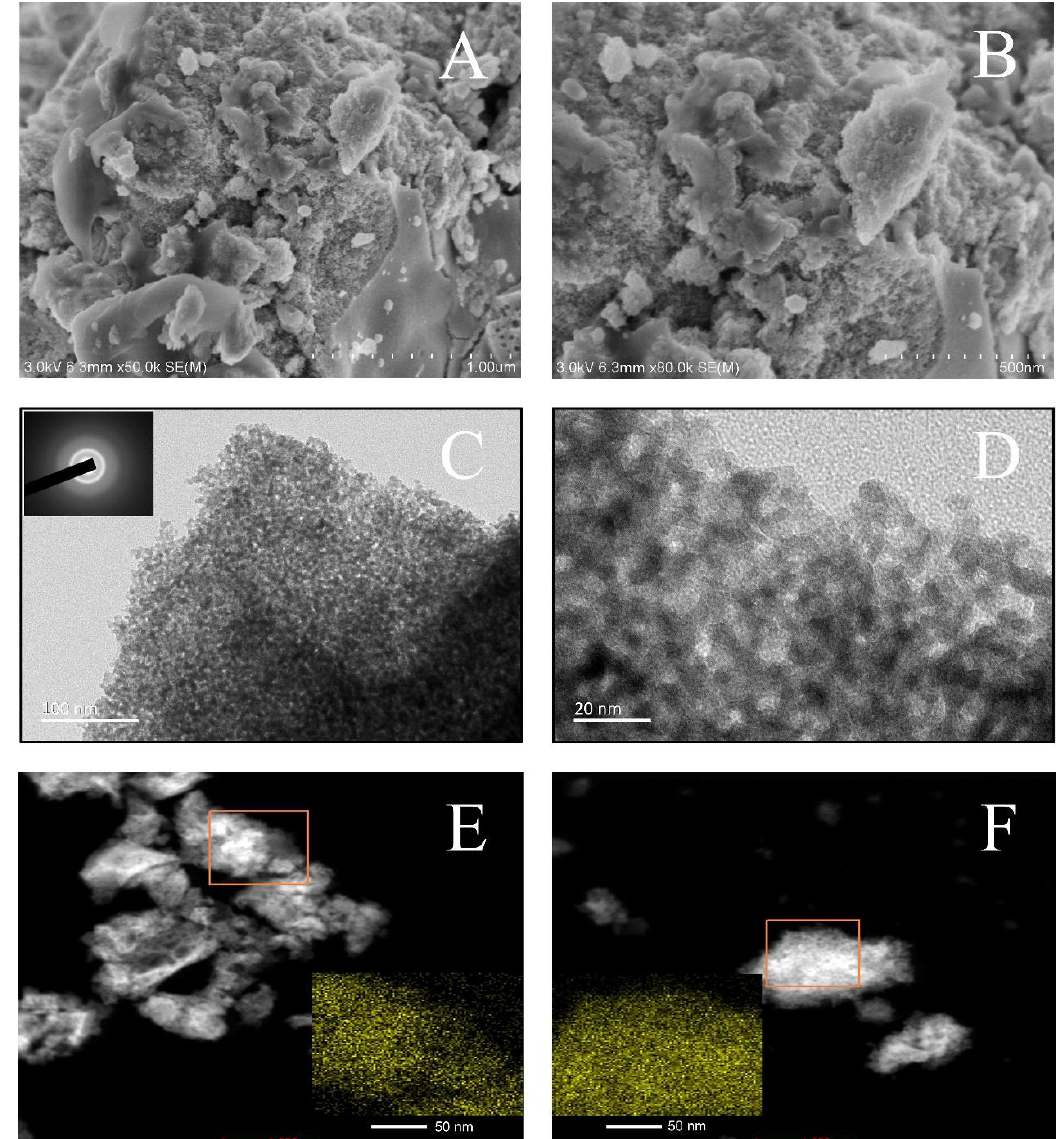
Figure 6. Scanning electron microscope (SEM) ( A , B ) and transmission electron microscope (TEM) ( C , D ) images of MCZ-0.67 catalyst, the inset is the pattern of the selected area electron diffraction (SAED). Scanning transmission electron microscope (STEM) images of MCZ-0.33 ( E ) and MCZ-0.67 ( F ) catalysts, the insets are Mn-element mappings.